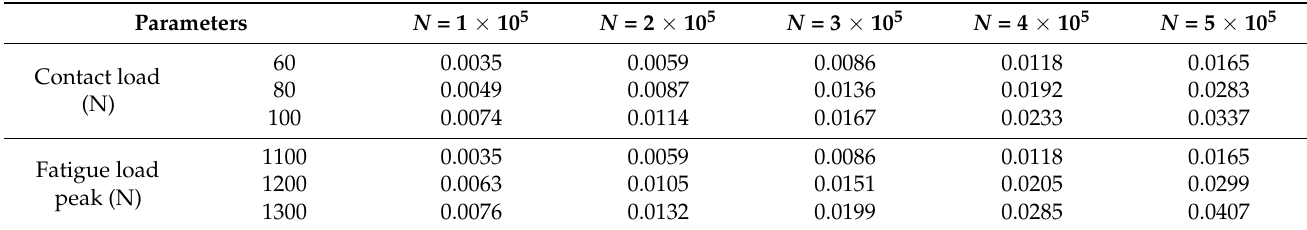
Table 2. Cross-sectional failure area of fatigue wire (pair: wire) under different contact and fatigue loads.